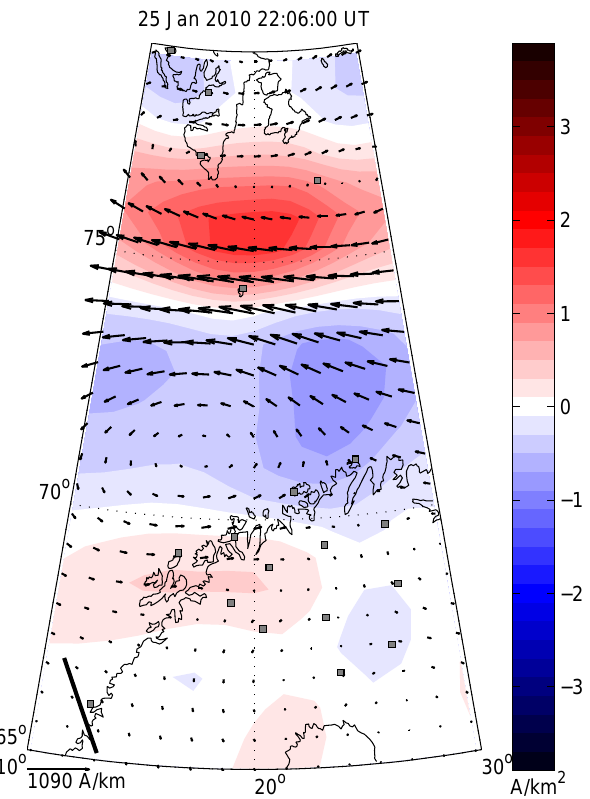
Fig. 12. Horizontal distribution of equivalent currents (black vec- tors) from the IMAGE magnetometer data during substorm 3. The blue and red colours indicate field-aligned current density up and down, respectively, estimated as the vorticity of the horizontal currents. The strongest currents occurred in the onset region at 22:06UT.